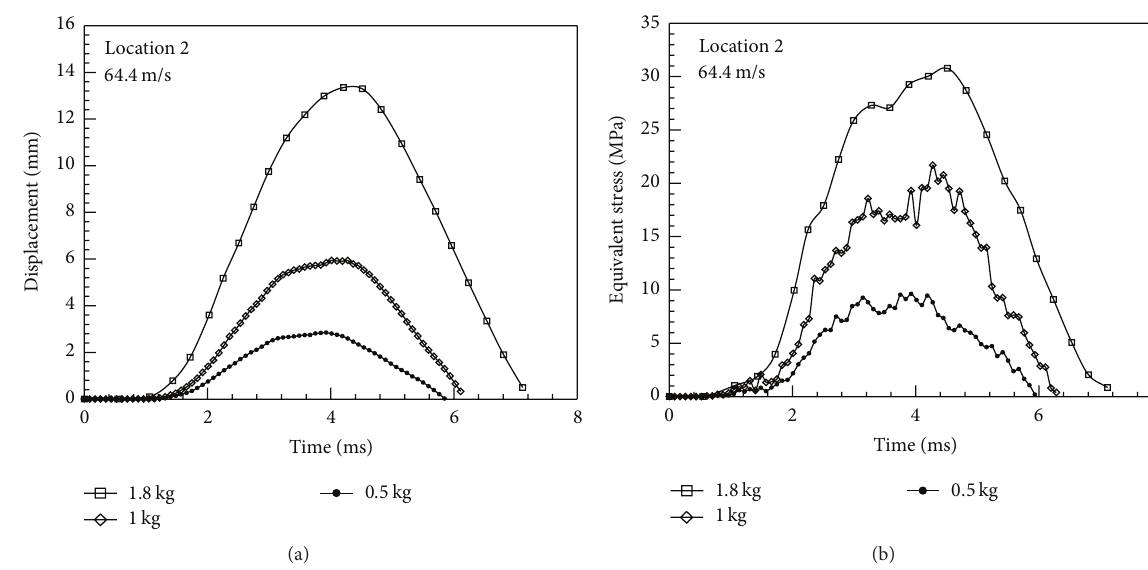
Figure 20: Effect of bird mass on (a) maximum normal displacement and (b) equivalent